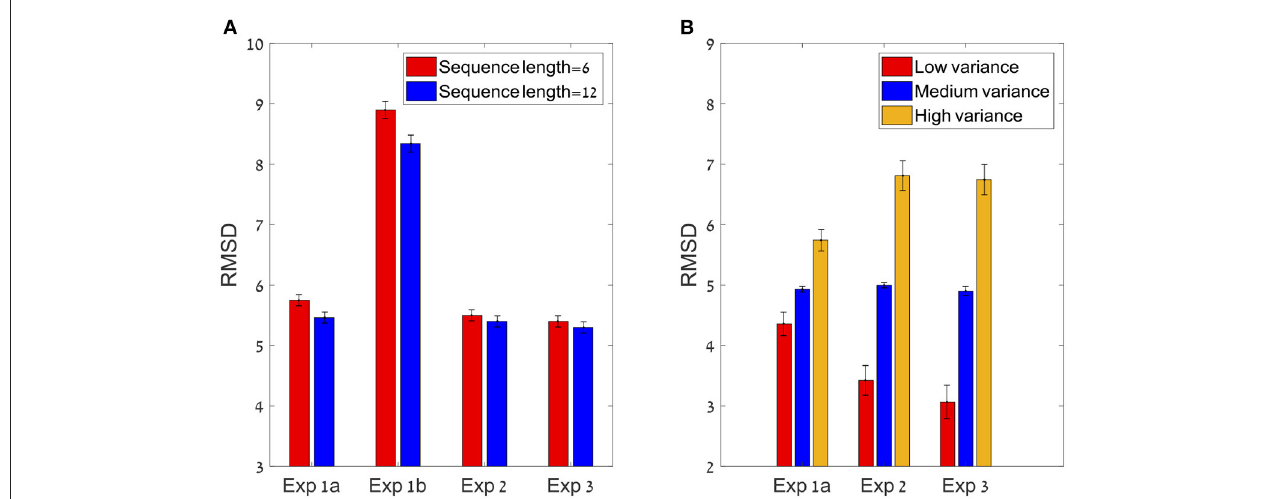
FIGURE 11 | Models’ best fit account of behavioral patterns. In order to test whether the models account for the sequence length and variance effect (see Figures 4A,B ), we simulated the best fit predictions in each experiment (for the variance effect we simulated only experiments 1a, 2, and 3 in which variance was manipulated). (A) Models prediction to the sequence length effect. (B) Models prediction to the variance effect in experiment 1a, 2, and 3. All predictions are based on best fit model (and parameters) for each participant.